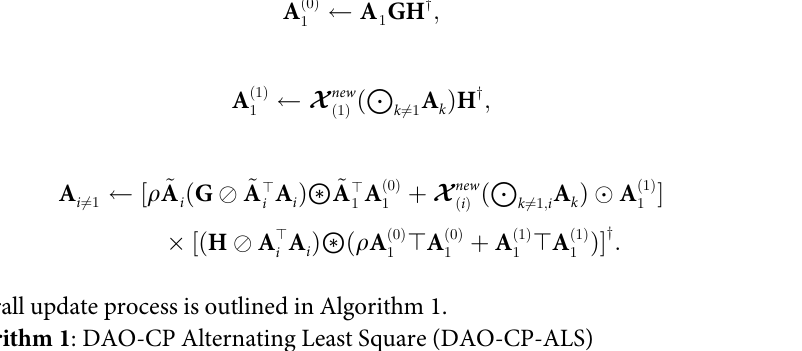
Algorithm 1 : DAO-CP Alternating Least Square